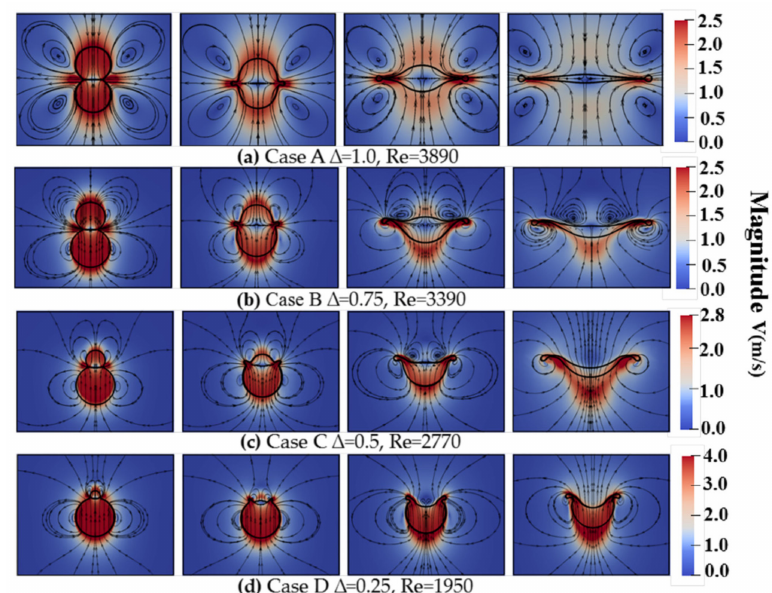
Figure 6. The streamlines and the velocity magnitude from the mixture at the cross-section Z = 0.003125 under the di ff erent size-ratios of 0.75, 0.50, and 0.25 at T = 0.00, 0.59, 1.62 and 3.63, respectively. ( a ) CaseA ∆ = 1.0, Re = 3890, ( b ) CaseB ∆ = 0.75, Re = 3390, ( c ) CaseC ∆ = 0.5, Re = 2770, ( d ) CaseD ∆ = 0.25, Re =